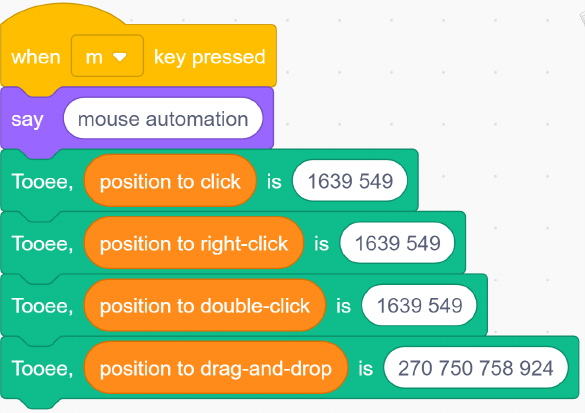
Figure 6. An example program that automates the mouse using the mouse cursor coordinates. In this example, the program performs a total of 4 operations: (1) “click”, (2) “right-click”, (3) “double-click”, and (4)